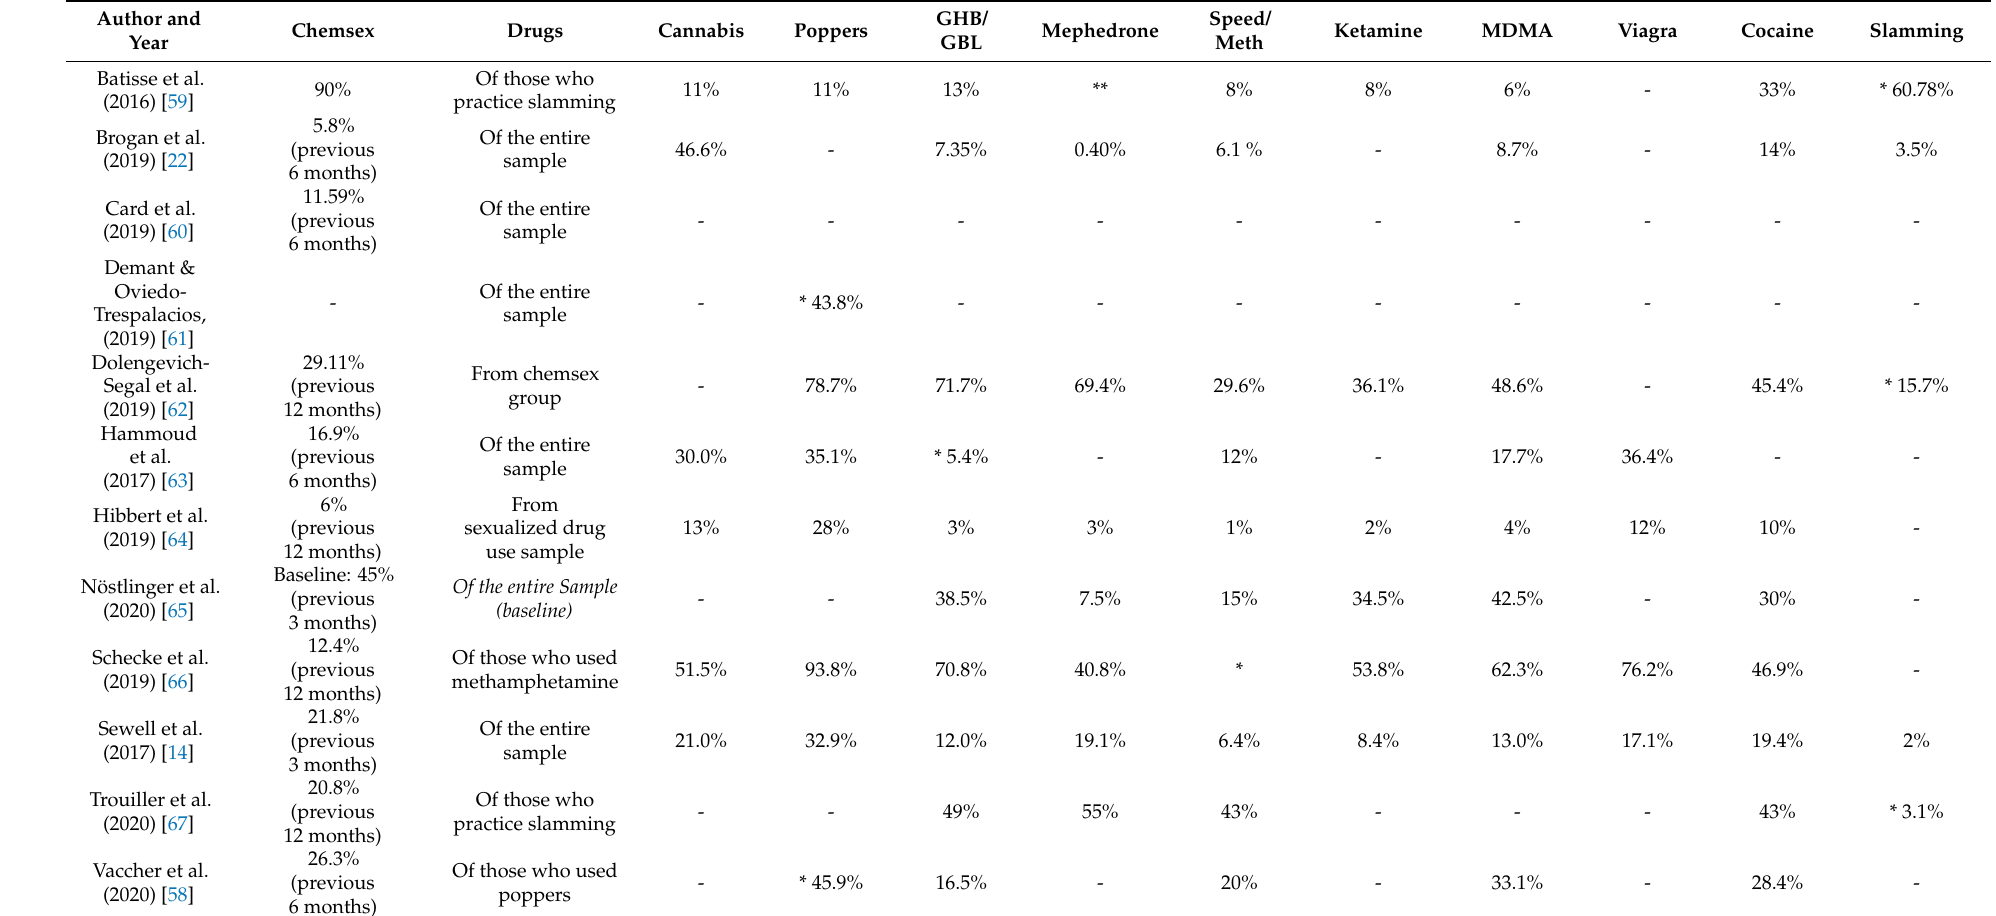
Table 3. Consumer drugs in included